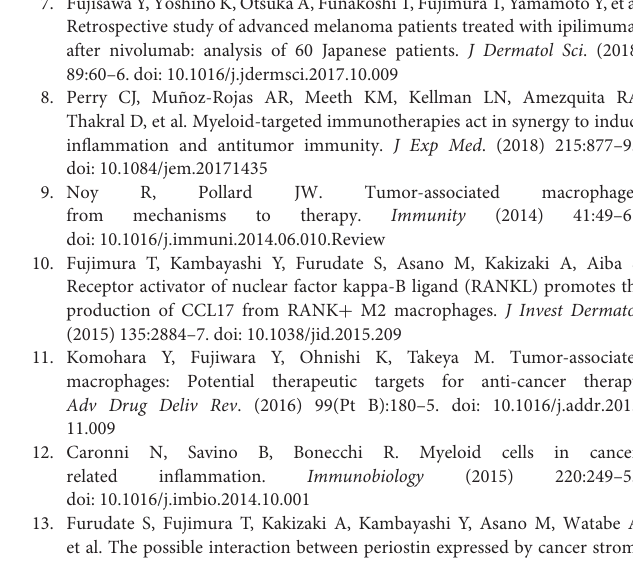
Supplemental Figure 1 | Serum levels of sCD163 at day 0 in patients with cutaneous and non-cutaneous melanoma. Mean serum levels of sCD163 in responders ( n = 13) and non-responders ( n = 46) at day 0 (A) . Mean serum levels of sCD163 in responders ( n = 4) and non-responders ( n = 12) at day 0 (B) n.s, not